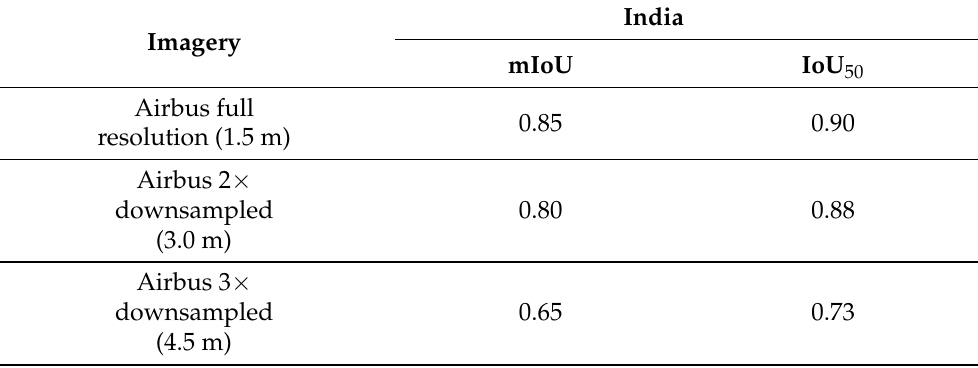
Table A1. Downsampling Airbus imagery decreases field delineation performance in India. Iden- tical evaluation across the three rows allows us to isolate the effect of image resolution on field delineation performance. Performance declines moderately when Airbus imagery is downsampled by a factor of 2, and performance declines more steeply when Airbus imagery is downsampled by a factor of